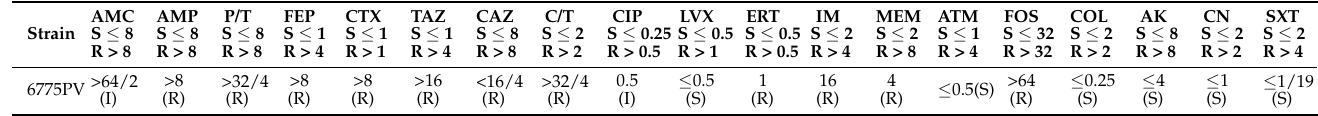
Table 1. Antibiotic susceptibility profiles of the 6775PV isolate. Interpretation was performed according to EUCAST breakpoints (version 12, 2022) for Enterobacterales: S was used for susceptible, I for susceptible increased exposure and R for resistant. Breakpoints are displayed under each antibiotic